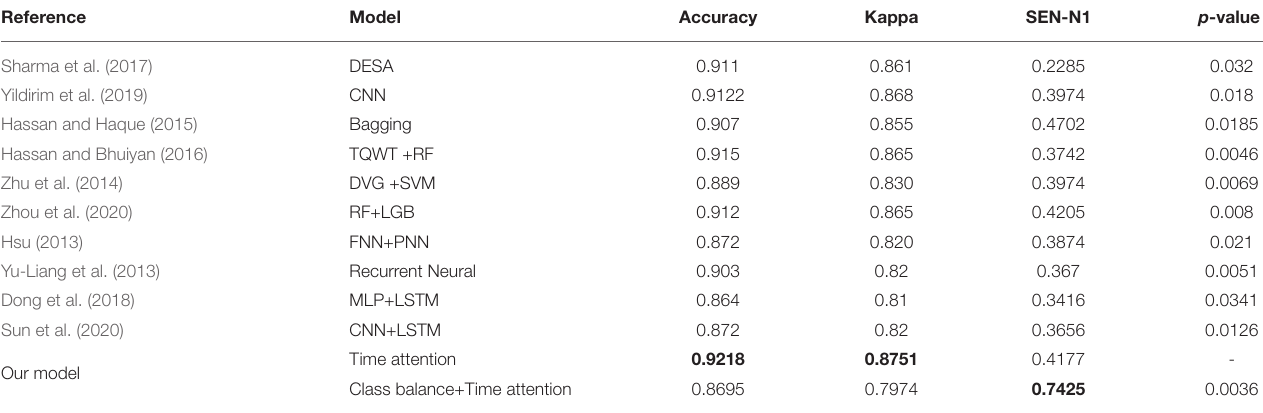
TABLE 8 | Performance comparison of proposed algorithm with state-of-the-art studies in 5-class sleep staging on sleep-EDF